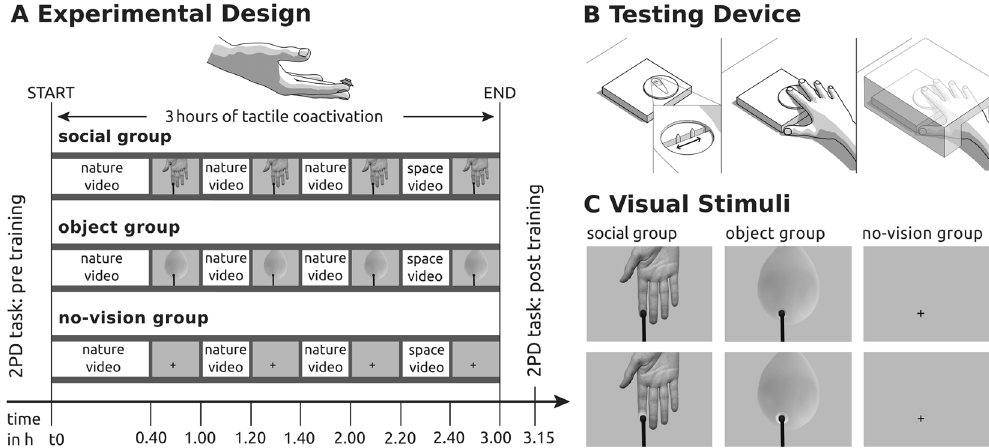
Figure 2. Stimuli and experimental design. ( A ) The two-point discrimination task (2PD task) was applied once before and once after training (pre, post). Training comprised three hours of tactile coactivation applied by a small loudspeaker membrane attached to the right index fingertip (see schematic drawing upper panel). During tactile coactivation, all participants watched nature and space videos, or were exposed to different visual stimulus conditions (four blocks, 20 minutes each, also see ( C )). Participants of the “social group” watched synchronous touches to a hand, participants of the “object group” watched synchronous touches to a balloon, participants of the “no-vision group” saw a fixation-cross that changed in colour. Time is given in hours (h). ( B ) Testing device. A fully automated Piezo-electric stimulator was used to measure two-point discrimination thresholds. During the 2PD task, vision of the right hand was precluded by a white box. ( C ) Enlarged presentation of the visual stimulus material as introduced in ( A ).